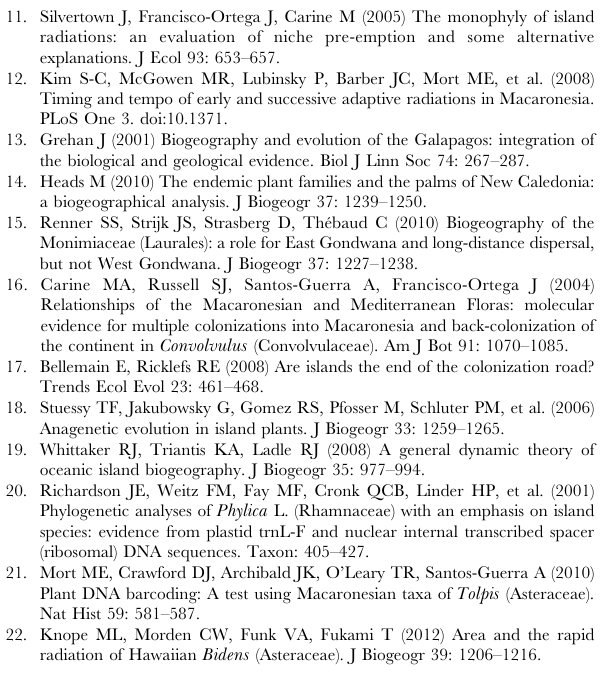
Table S3 Data from diagnostic morphological charac- ters of Canarian Cheirolophus species. Character loadings